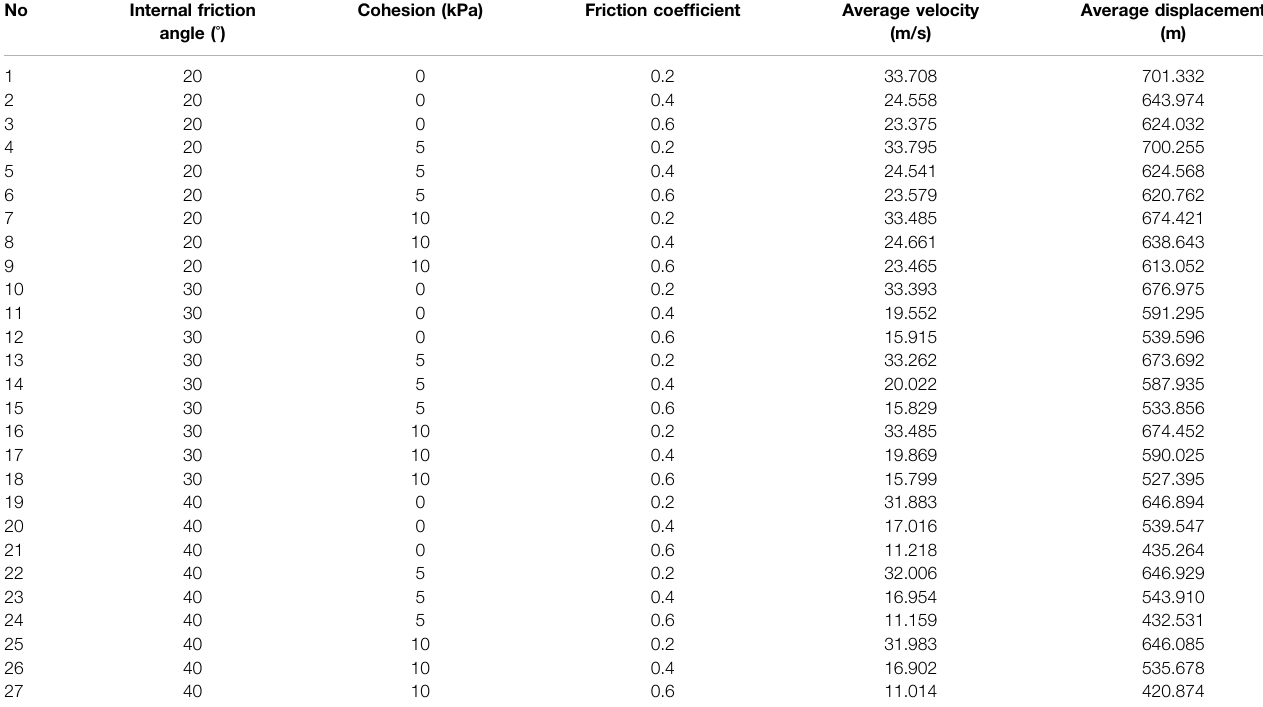
TABLE 2 | Numerical calculation results.